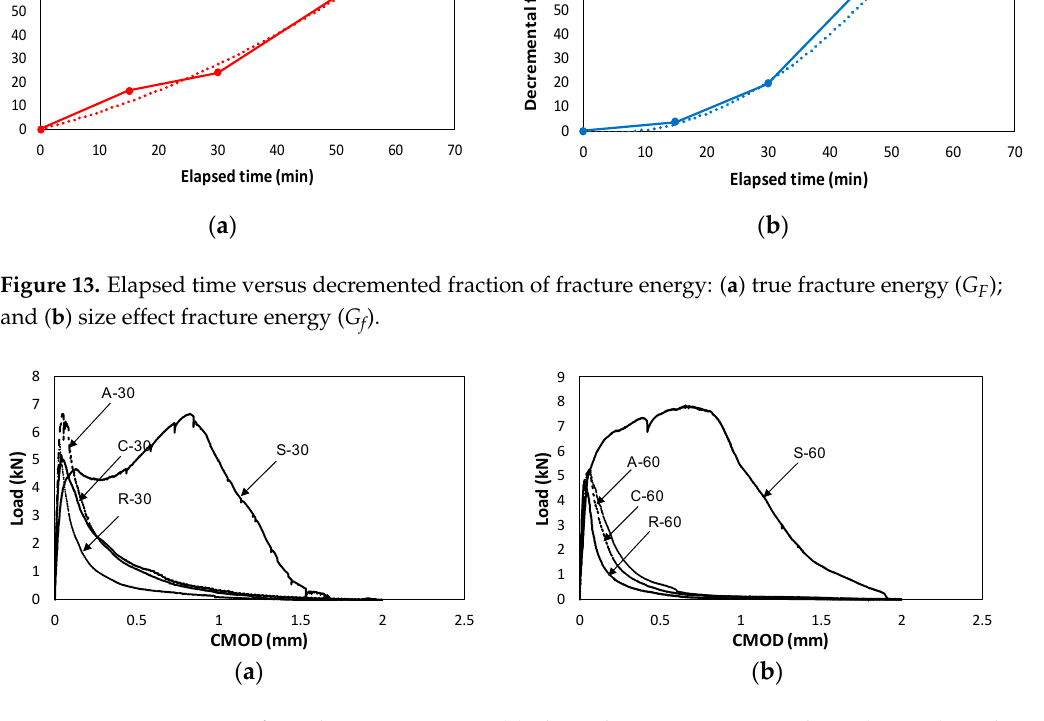
Figure 14. Comparison of Load–CMOD curves: ( a ) elapsed time to meet new layer (30 min); and ( b ) elapsed time to meet new layer (60 min).